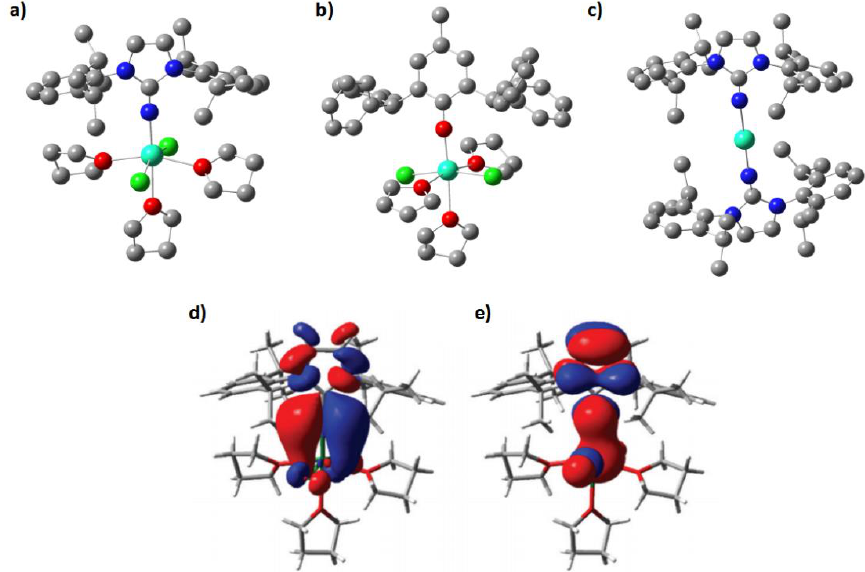
Figure 6. ( a , b ) Crystal structure of 1 and 2 . ( c ) Geometric structure of the model complex with linear Im Dipp NH ligands coordinated. ( d , e ) Isosurfaces of HOMO orbitals for 1 and 2 . Dy, dark cyan; C, gray; N, blue; Cl, green; O, red. All hydrogen atoms are omitted for clarity (adapted with permission from [48]).